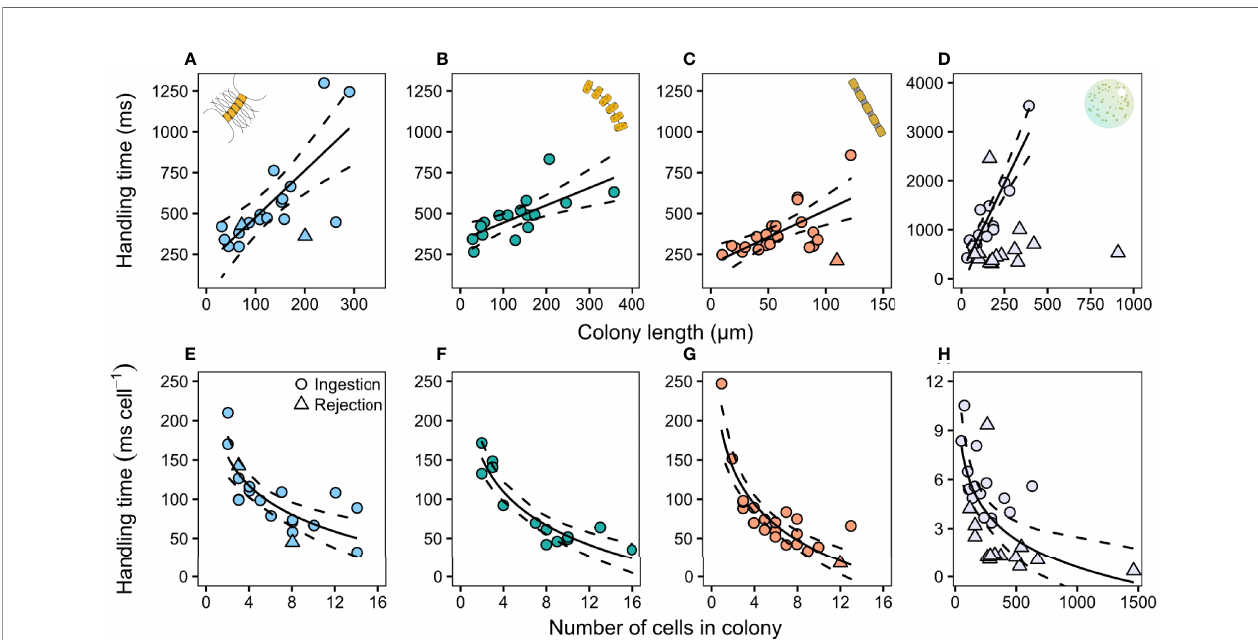
FIGURE 3 | Relation between copepodite handling time (ms) and colony size (top row) and handling time cell − 1 (ms cell − 1 ) and the amount of cells in the colony (bottom row) in (A, E) C. af fi nis , (B, F) T. nordenskioeldii , (C, G) S. marinoi , and (D, H) P. globosa . Each individual point represents one capture event. The number of cells per colony in P. globosa was estimated based on Jakobsen and Tang (2002). Regression lines are summarized in Appendix 1: Table S1 . Dashed lines are 95% con fi dence intervals.